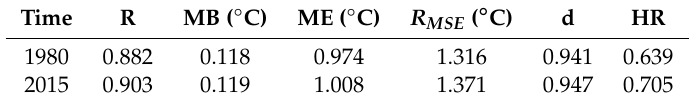
Table 11. Analysis of the 2-m temperature simulation results using land-use data from 1980 and